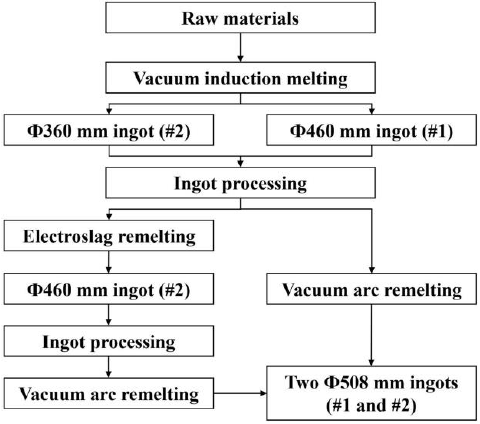
Figure 1. Schematic of the melting process.